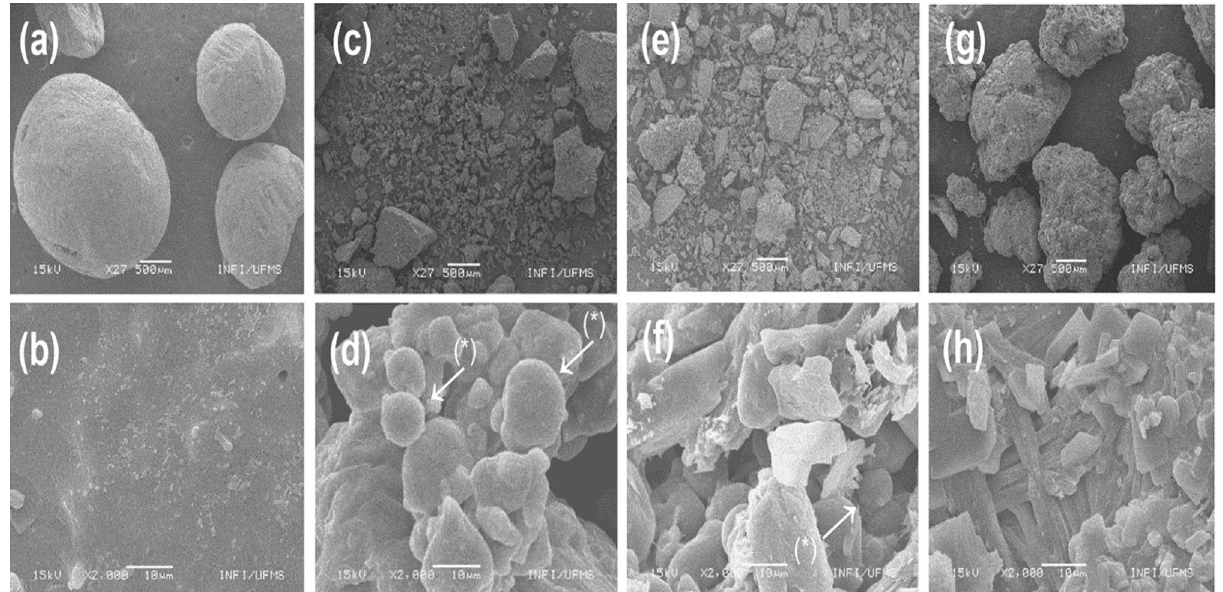
Figure 1. Scanning electron microscopy at 27 and 2000 times increases in urea ( a and b ), ground corn ( c and d ), corn and urea mixture ( e and f ), and extruded urea ( g and h ). (*) Starch granules.